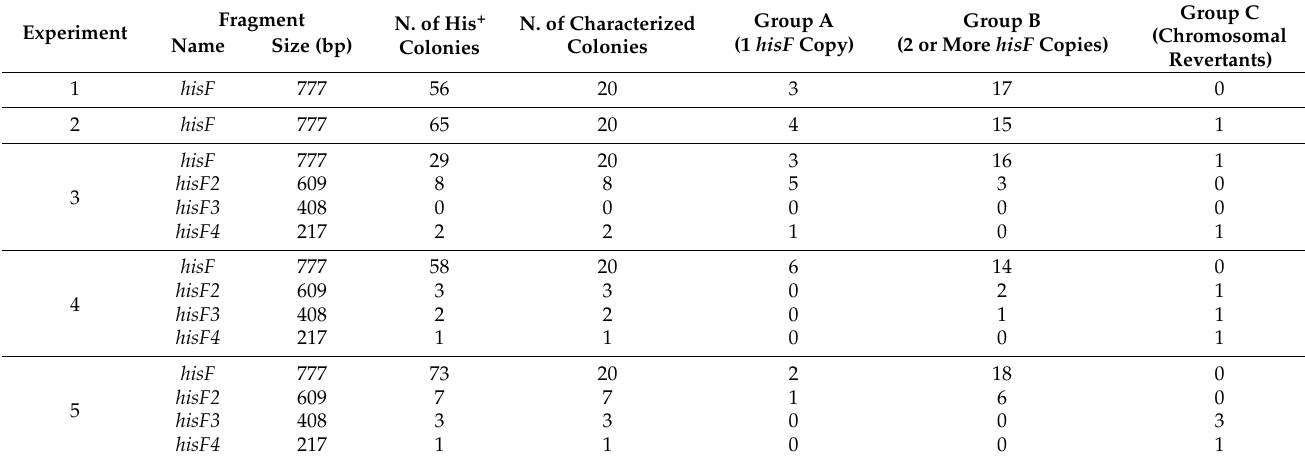
Table 4. Summary about His + colonies obtained after five CFGE experiments.